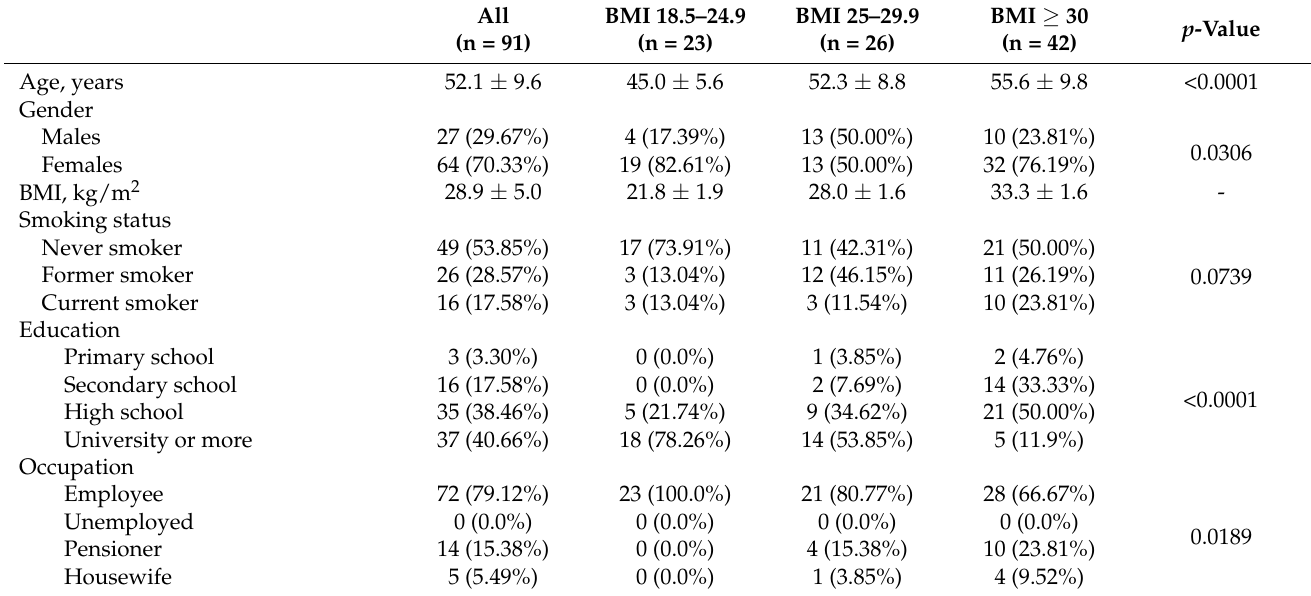
Table 1. Anthropometric, biochemical, and clinical features of enrolled